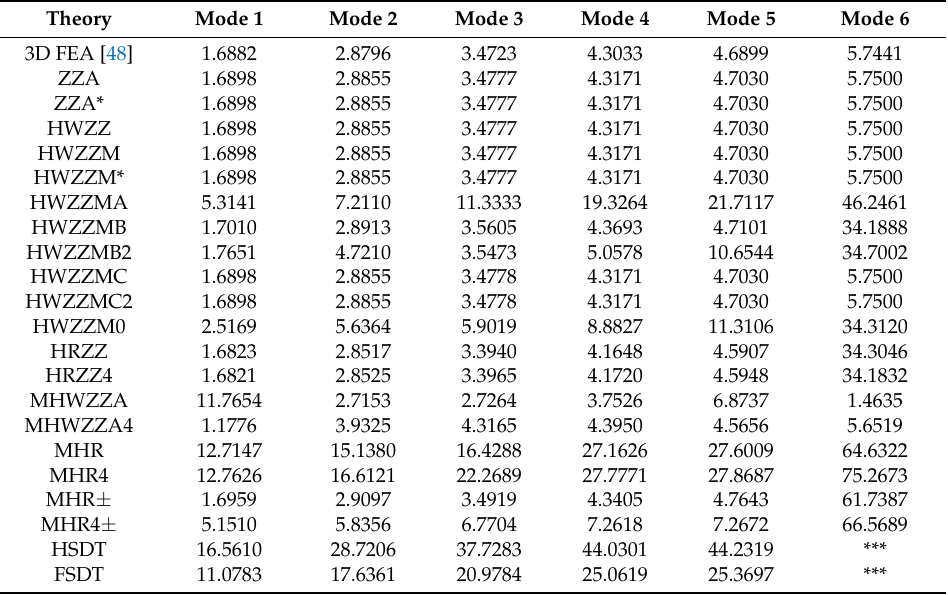
Table 19. Normalized fundamental frequencies, case